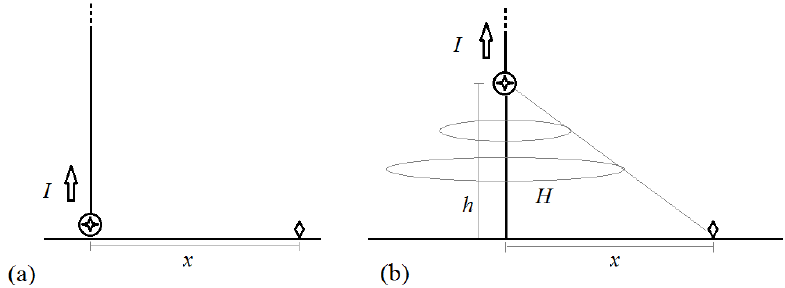
Figure 1. ( a ) Return stroke at the ground level; ( b ) Return stroke at the top of the